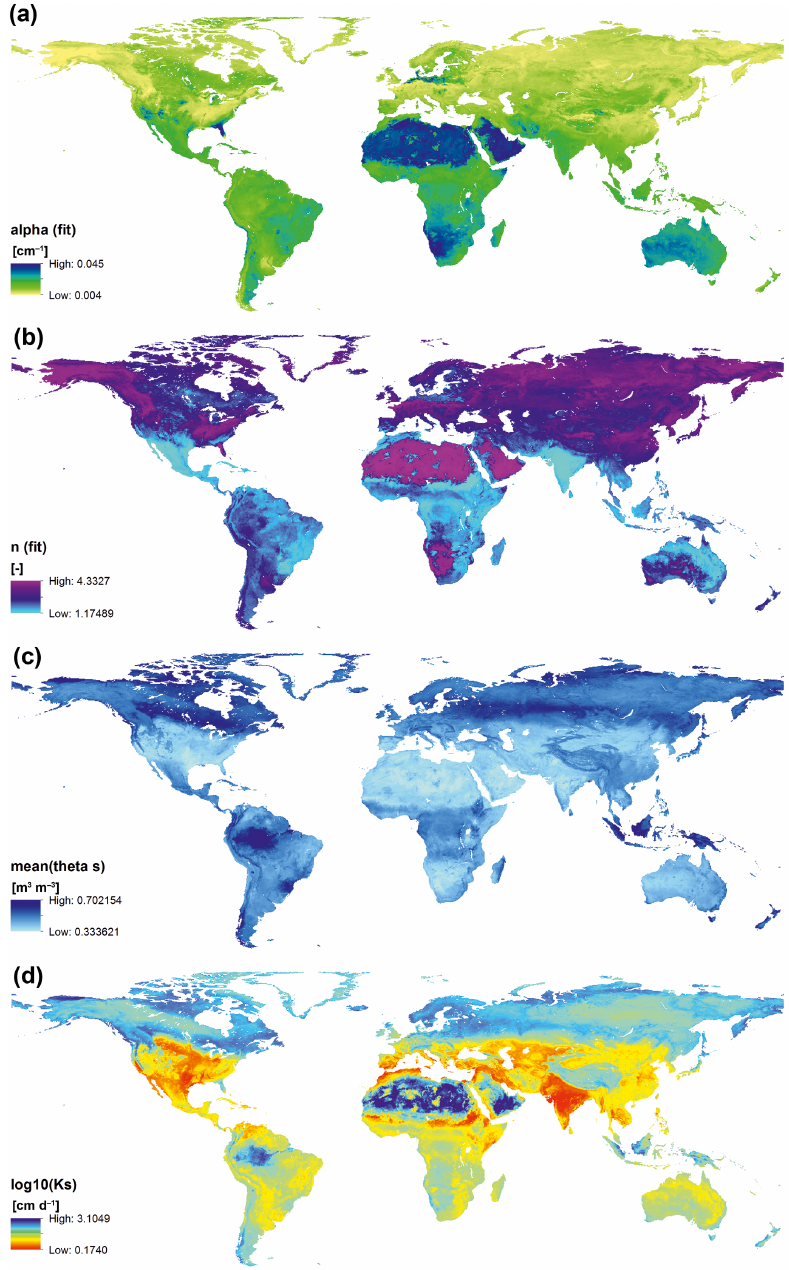
Figure 5. Global map of ˆ α (a) , ˆ n (b) , θ s (c) and mean(log 10 ( K s )) (d) , as derived when using the SoilGrids1km data set as input to the Rosetta PTF (Schaap et al., 2001), at 0.25 ◦ spatial